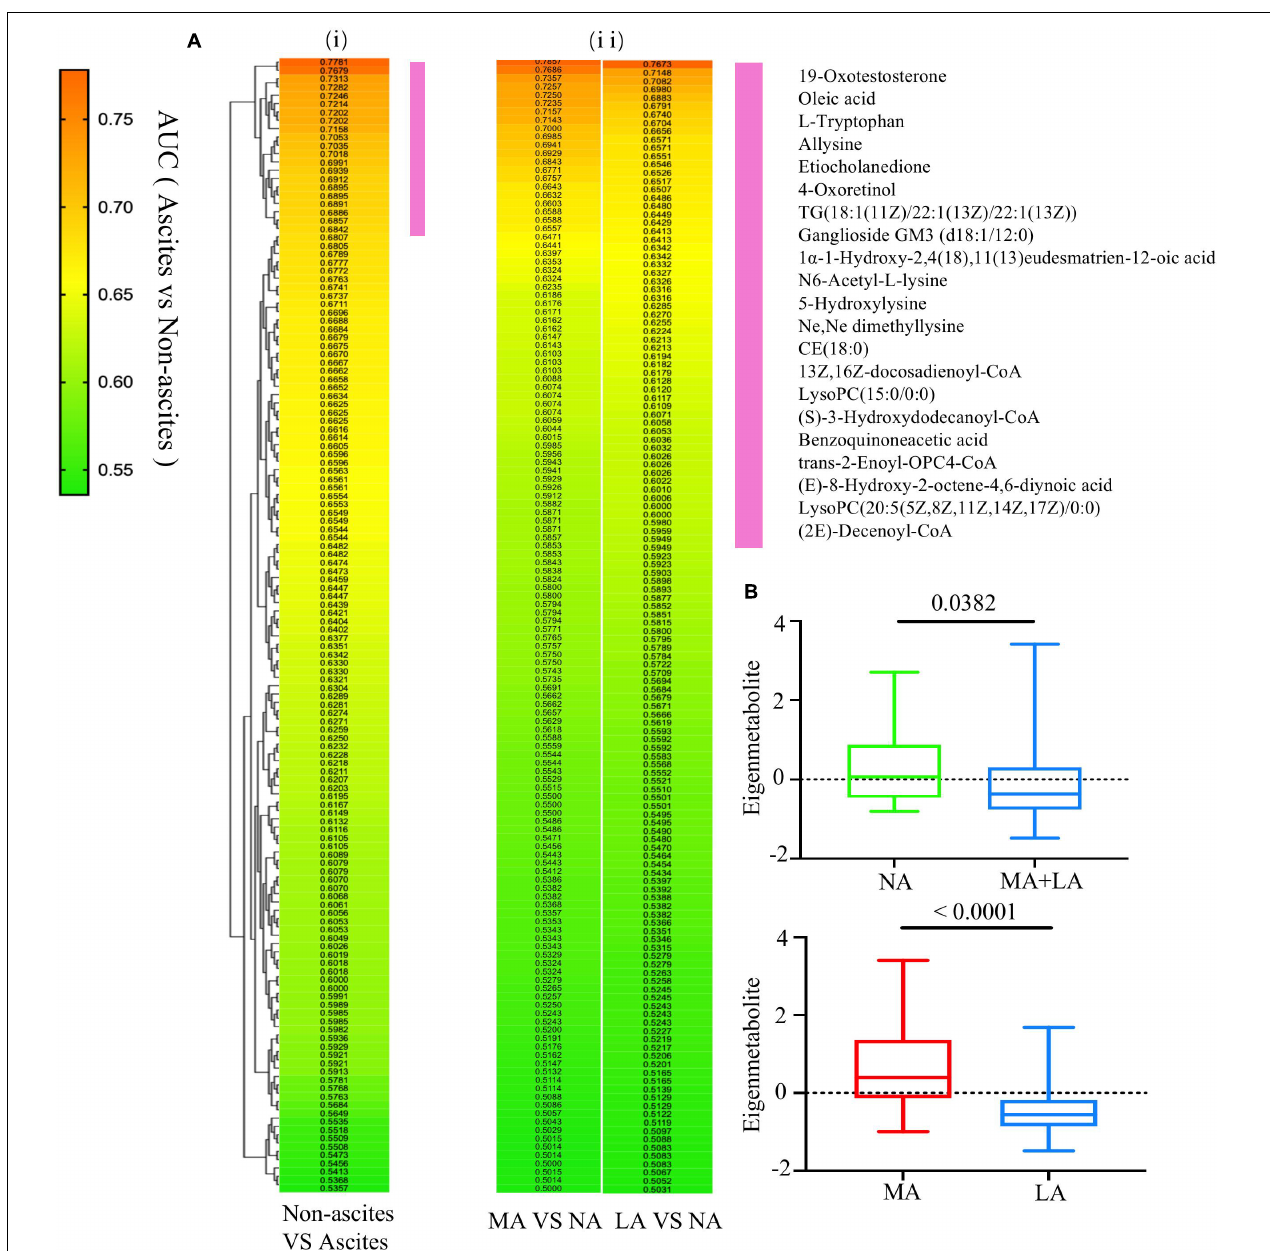
FIGURE 2 | Selection of metabolic fingerprints uniquely expressed in ALD patients with ascites. (Ai) Hierarchical cluster analysis of the AUCs and p value assessing the discriminating accuracy of each of the 136 metabolites in differentiating ALD with or without ascites. (Aii) The corresponding metabolites’ AUC and P values in accessing MA or LA relative to NA. The vertical violet bar identifies the 21-metabolite clusters highly associated with ascites and the ascites-associated metabolite fingerprints. (B) The decreasing trend of the eigenmetabolite (21 fingerprint metabolites) in ALD patients without ascites and different stages of